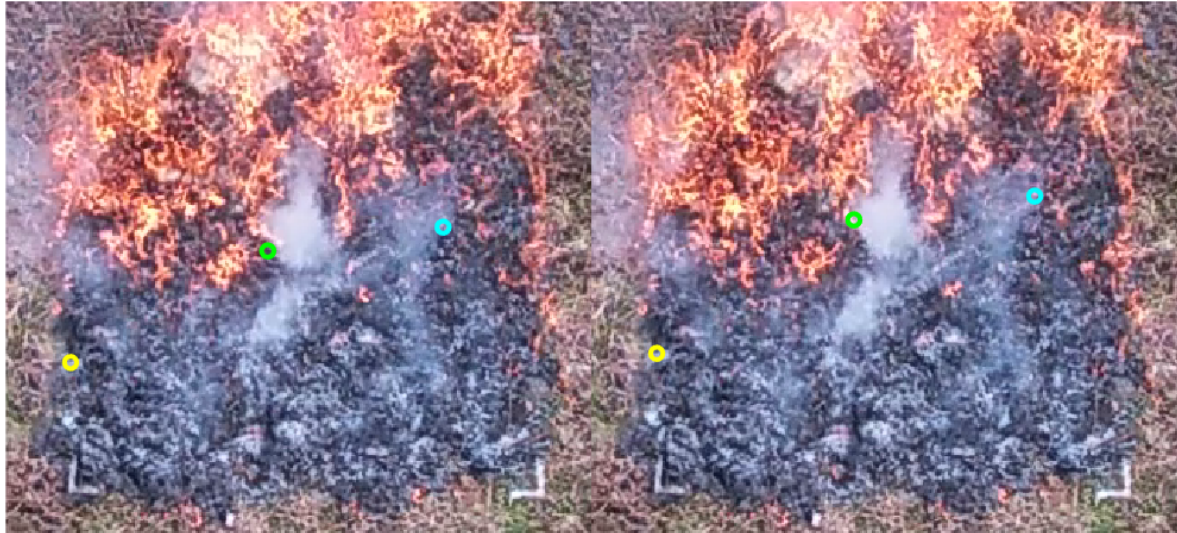
Figure 3. Sample points found in successive frames used to calculate wind speed along the longitudinal axis. The yellow points yielded a wind speed of approximately 1.3 m/s, the green points yielded a wind speed of approximately 4.4 m/s, and the cyan points yielded a wind speed of approximately 4.4 m/s; combined, the average wind speed in the positive longitudinal direction is 3.4 ± 0.8